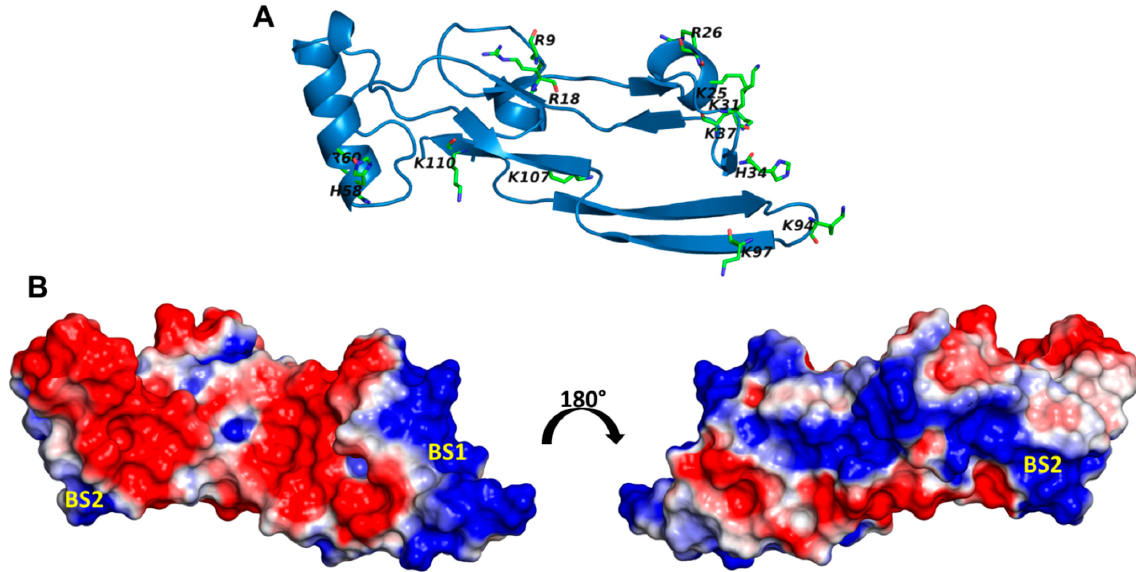
Figure 2. Electrostatic surface potential of TGF- β 2: ( A ) the structure of transforming growth factor (TGF- β 2) extracted from PDB (1TGF) showing the basic residues; ( B ) two potential GAG-binding sites (BS1 and BS2) identified based on electrostatic surface potential.